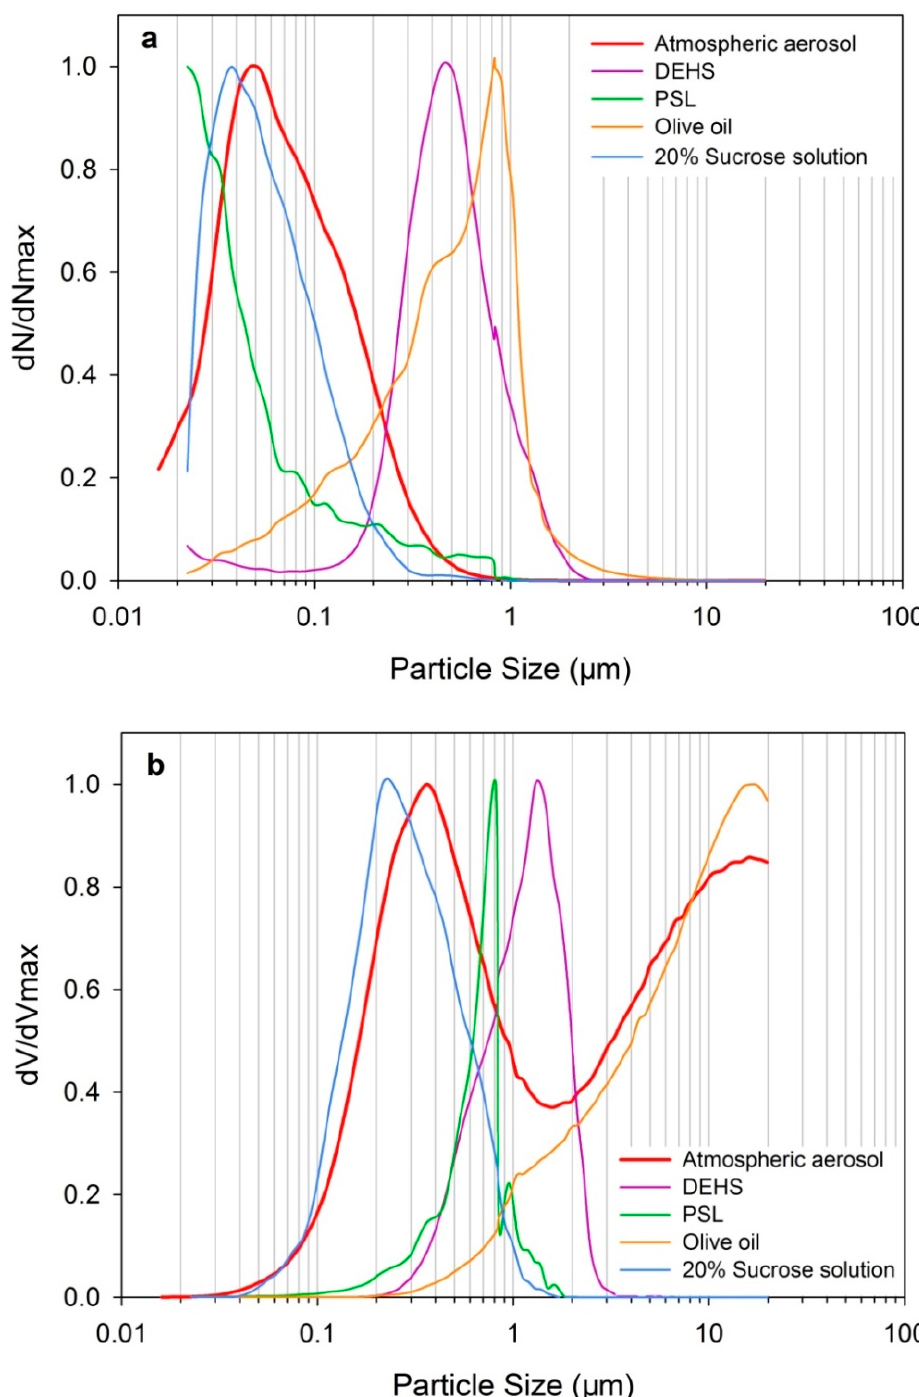
Figure 2. Normalized particle number ( a ) and volume ( b ) size distribution.